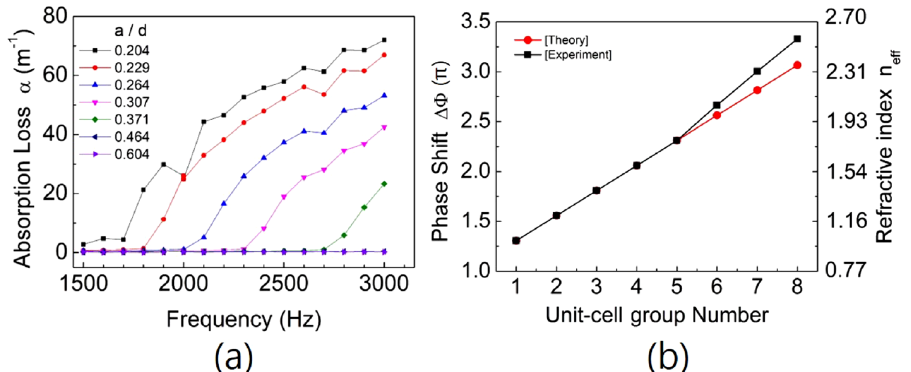
Figure 2. ( a ) shows the values of the absorption loss for the acoustic waves with respect to the frequency and structure ratio of the unit-cell group of the metasurface. ( b ) shows the change in the phase shift of the unit-cell group that consists of four 1D FCOC unit cells. In this figure, the unit-cell group number indicates the order of the unit-cell group in the periodic group. These adjacent unit-cell groups are designed to have different phase values of π/ 4 to each other. Black squares and red dots with lines show the experimental and theoretical values of the phase change (or refractive index) of the unit-cell groups with different structure